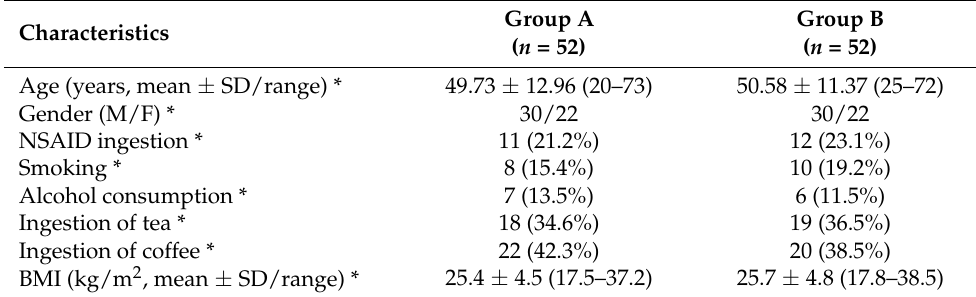
Table 1. Clinical characteristics of Helicobacter pylori infected